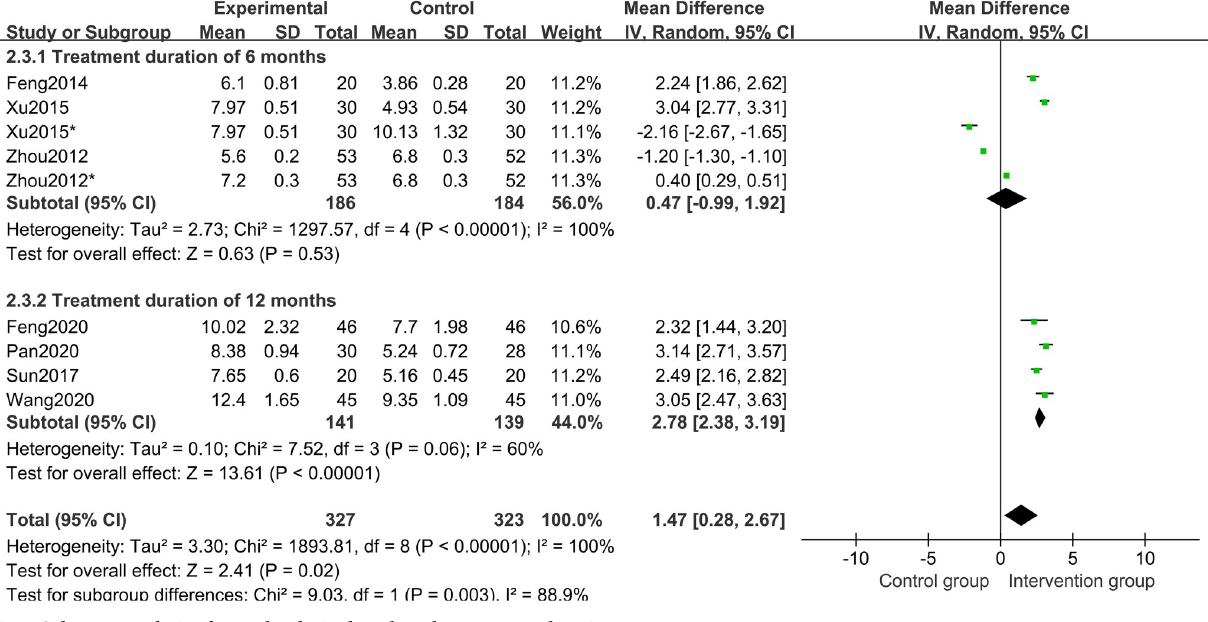
Fig 7. Subgroup analysis of growth velocity based on the treatment